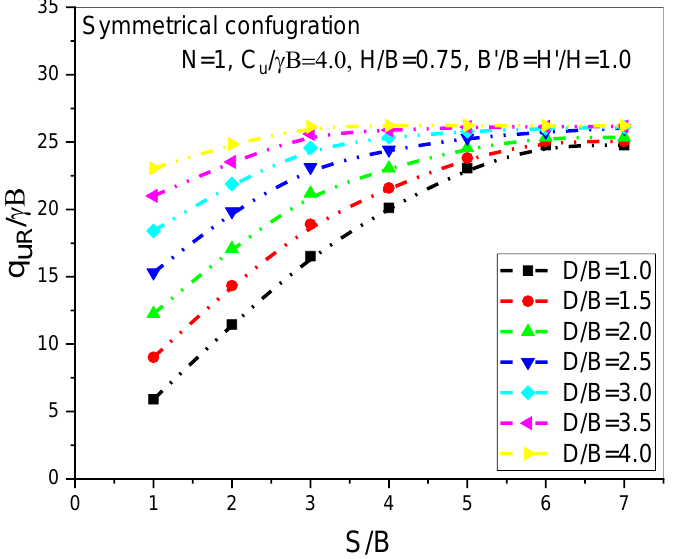
Figure 20. Effect of reinforcement on the ultimate bearing capacity ratio with a change in the symmetrical configuration of the two voids.